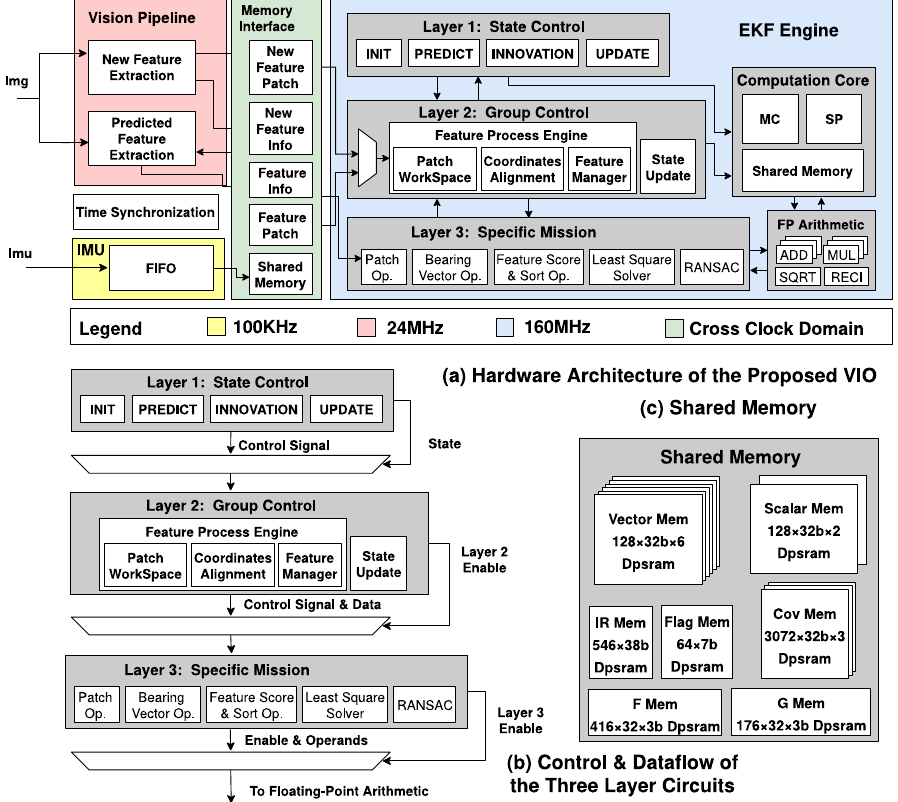
Figure 5. Overall hardware architecture of the proposed accelerated core. ( a ) Hardware architecture of the proposed VIO accelerated core; ( b ) control and dataflow of the three-layer circuits; ( c ) shared memory for the storage of vectors and matrices.